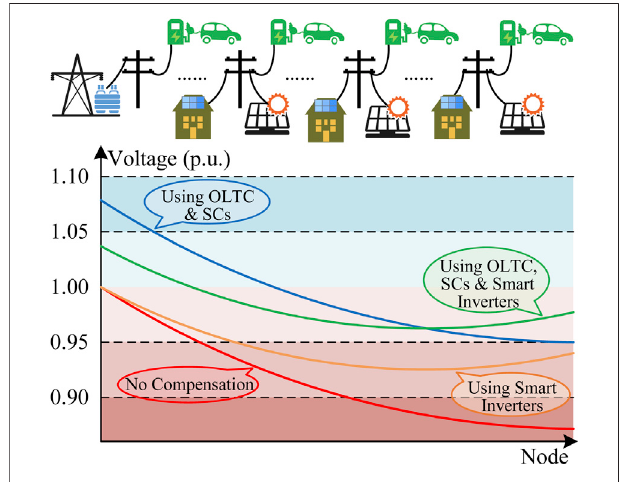
FIGURE 3 | Voltage diagrams of different compensation